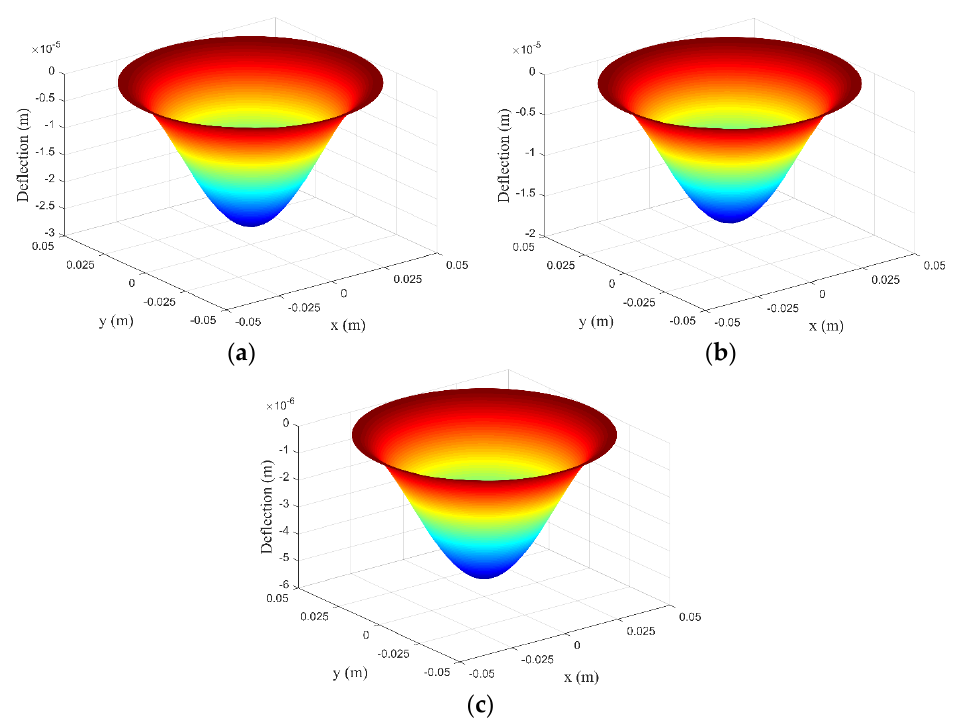
Figure 14. Static bending control of a circular PFGP through the displacement feedback control gain: ( a ) G d = 0; ( b ) G d = 5; ( c ) G d =